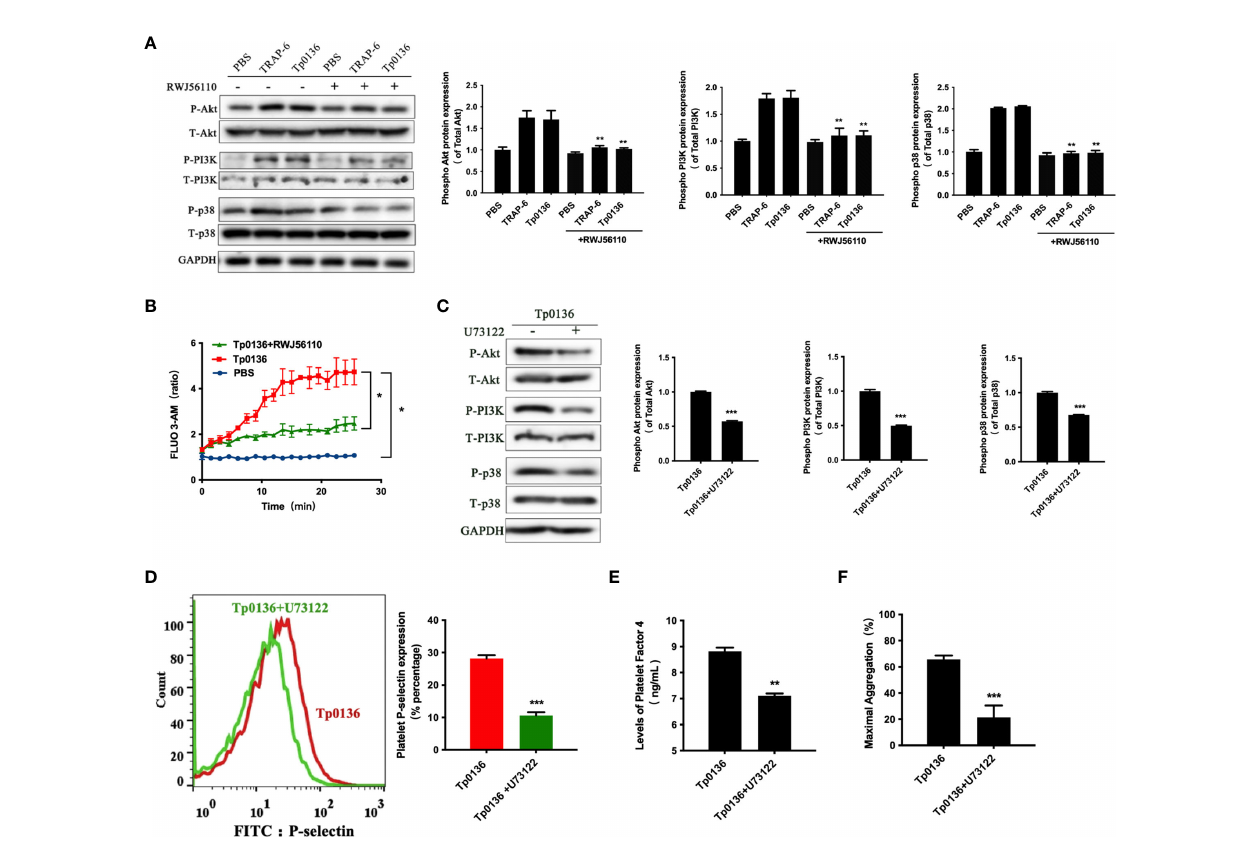
FIGURE 4 | Tp0136 enhanced G q signaling through PAR1 during platelet activation. (A) The protein expression of phosphorylated/total p38/Akt/PI3K and GAPDH was assessed by western blotting. (B) Cytosolic free Ca 2+ was measured by fl ow cytometry. (C) The protein expression of phosphorylated/total p38/Akt/PI3K and GAPDH was assessed by western blotting. (D) Expression of platelet P-selectin as measured by fl ow cytometry. A representative histogram is shown. (E) PF4 as determined by ELISA. (F) Maximal platelet aggregation as determined by an aggregometer. The values are presented as the mean ± SEM of experimental triplicates and are representative of the results of three independent experiments. Comparisons between the two groups were analyzed using a paired t-test. Differences in the calcium levels over time were determined by repeated-measures ANOVA followed by Dunnett ’ s post hoc test (* P < 0.05, ** P < 0.01, *** P <